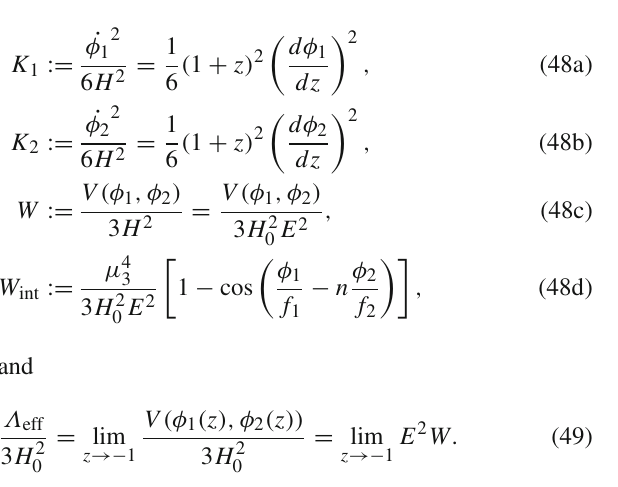
˙ H / H 2 for our model and for Λ CDM as a func- ter q := − 1 − tion of the redshift z . In Fig. 1h we present the evolution of the axion-like fields φ 1 and φ 2 as a function of the redshift z . According to Fig. 1h the values φ 1 = 0 . 061 and φ 2 = 0 .